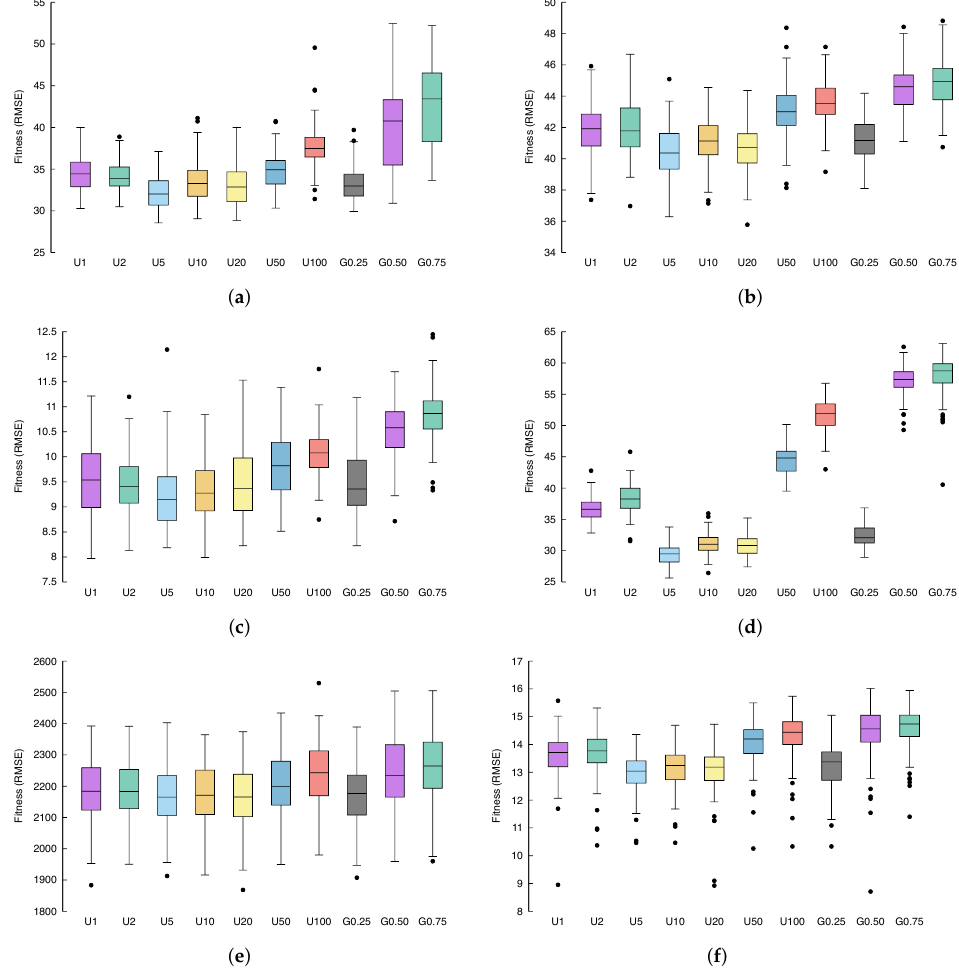
Figure 3. Box-plots of the RMSE on the training set over 100 independent runs of the considered benchmark dataset for all the proposed methods. ( a ) Air; ( b ) %F; ( c ) conc; ( d ) %PPB; ( e ) LD50; ( f )